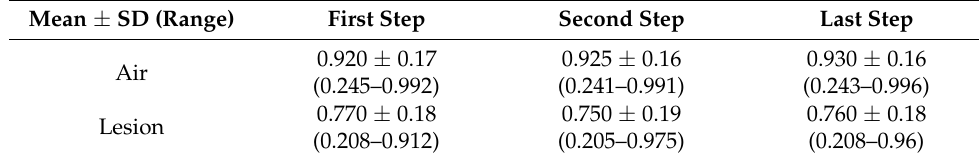
Figure 3. Best (first rows) and worst (second rows) from the test dataset (internal dataset—KUAH) at different analysis points: ( a ) first step, ( b ) second step, and ( c ) last step. Table 2. DSCs for the first, second, and last steps for the test dataset (20 cases) on